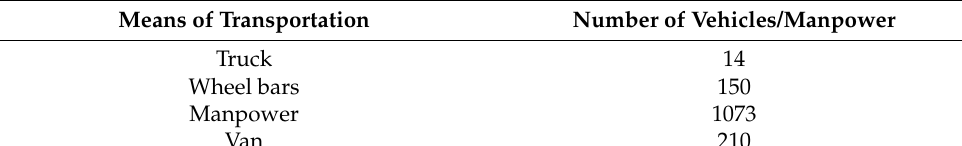
Table 4. Waste management facilities in RCC (collected from RCC authority, 2018).